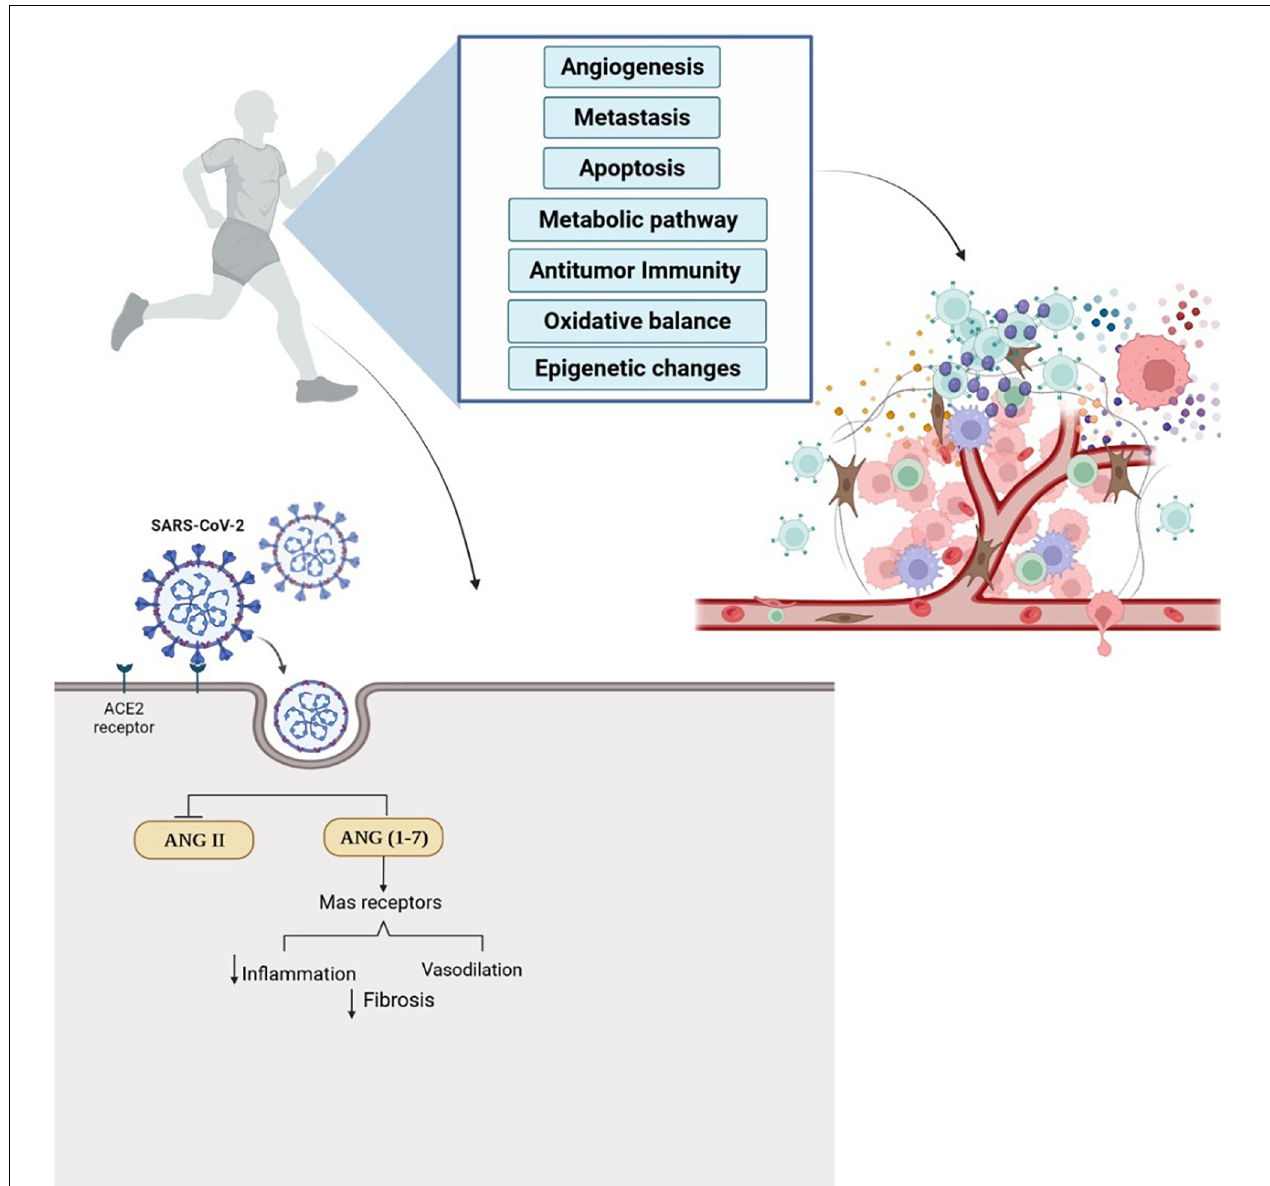
FIGURE 1 | Regular physical exercise can affect tumor microenvironment and induce anti-tumor immunity. Also, exercise training augments the expression of ACE2/ANG-(1-7) Mas receptor and activate anti-inflammatory pathways. Physical exercise simultaneously inhibits the ACE-Ang II-AT1 receptor pathway, inflammatory molecules, and oxidative stress in different tissues and can decrease the possibility of infection with COVID-19. The effects of regular physical exercise on antitumor immunity and ACE2 receptors can probably help cancer patients in the prevention and treatment of COVID-19.